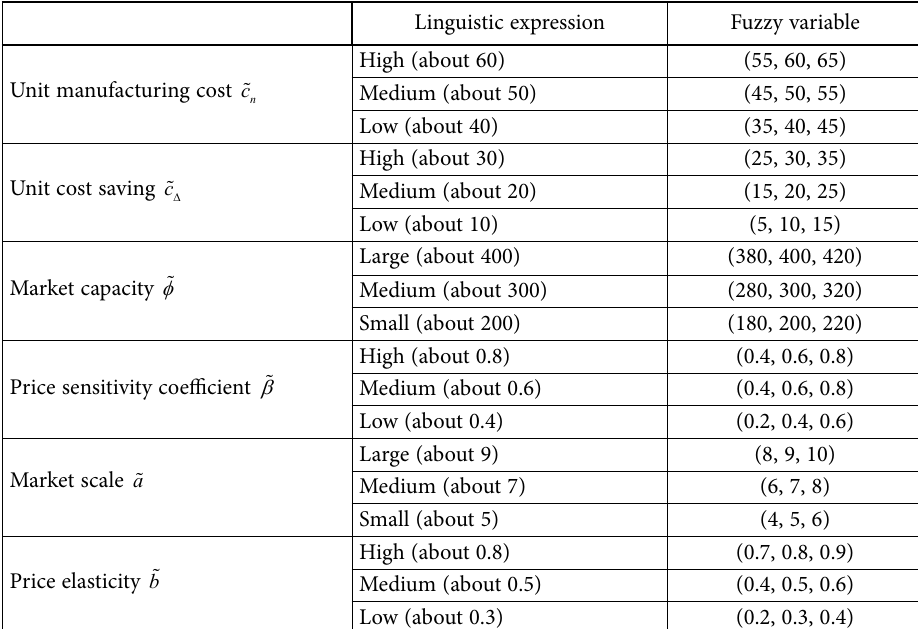
Table 2. Relationship between linguistic expression and triangular fuzzy variable Linguistic expression